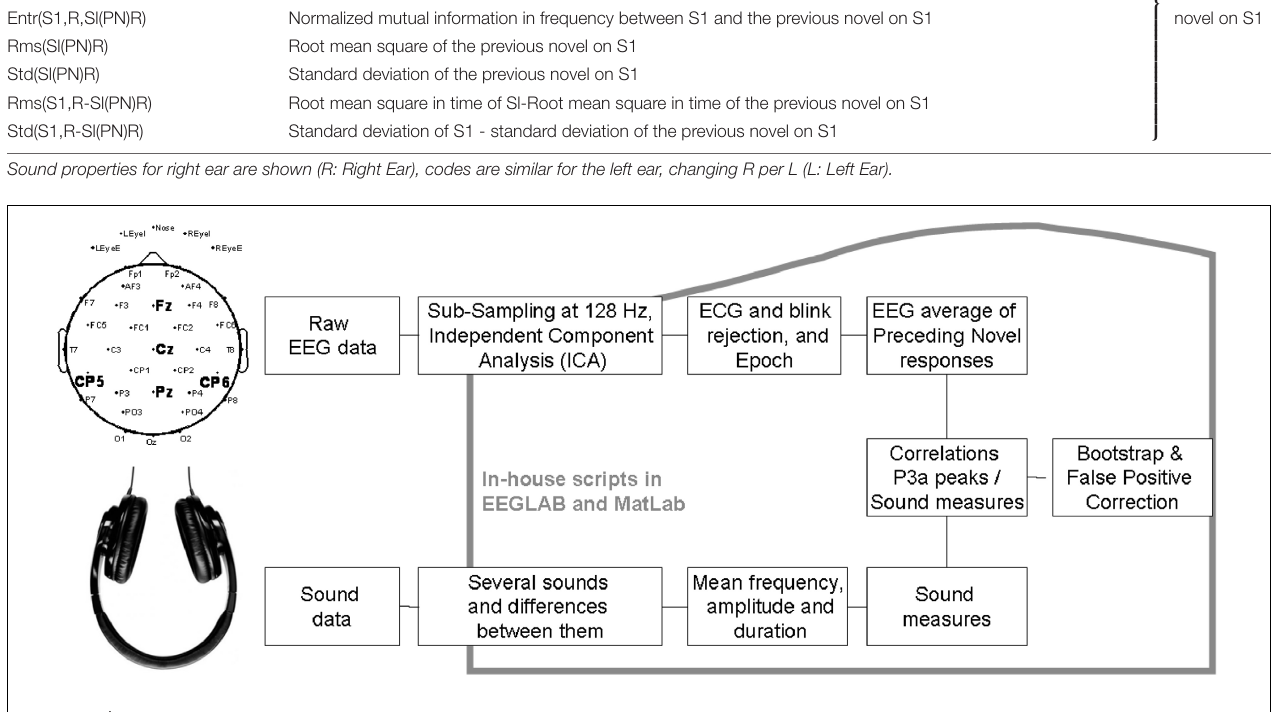
FIGURE 1 | Block diagram of data processing in the first